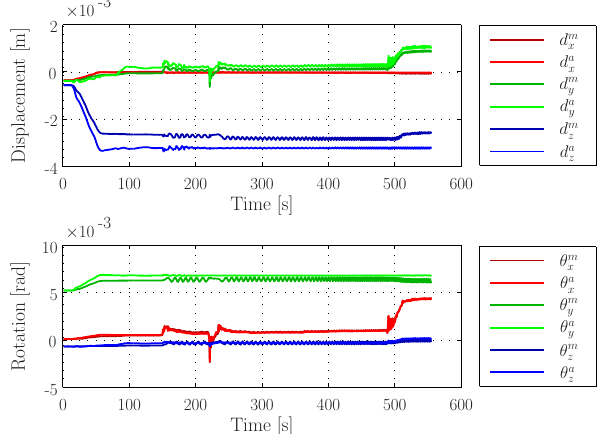
straint only allowing rotation about all 3 axes. The output shaft is locked against rotation about the x- axis. A torque is gradually applied at the hub flange of the main shaft. During simulation the rotation of the PLC was recorded at the upwind bearing of the